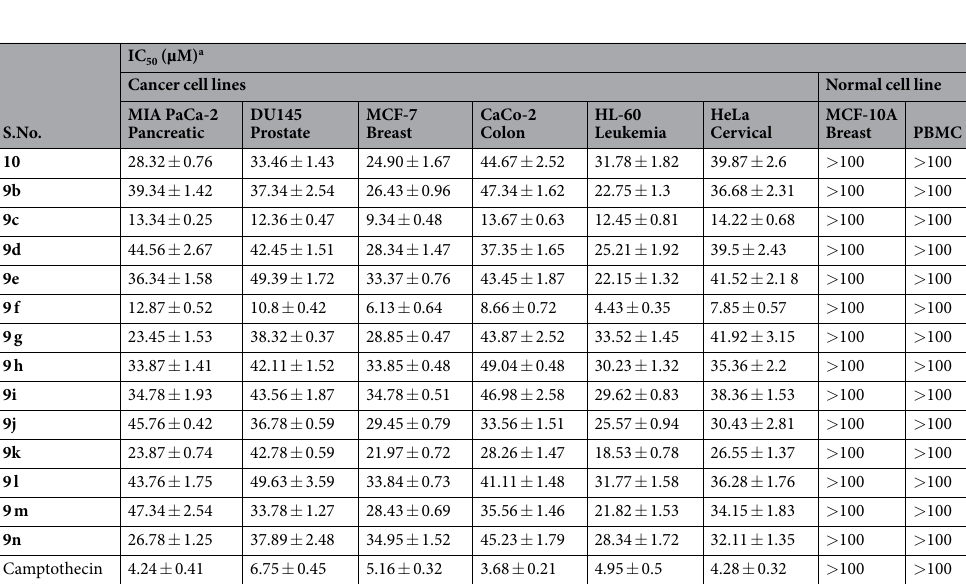
Figure 3. Structures of saccharumoside-B and its analog 9f .